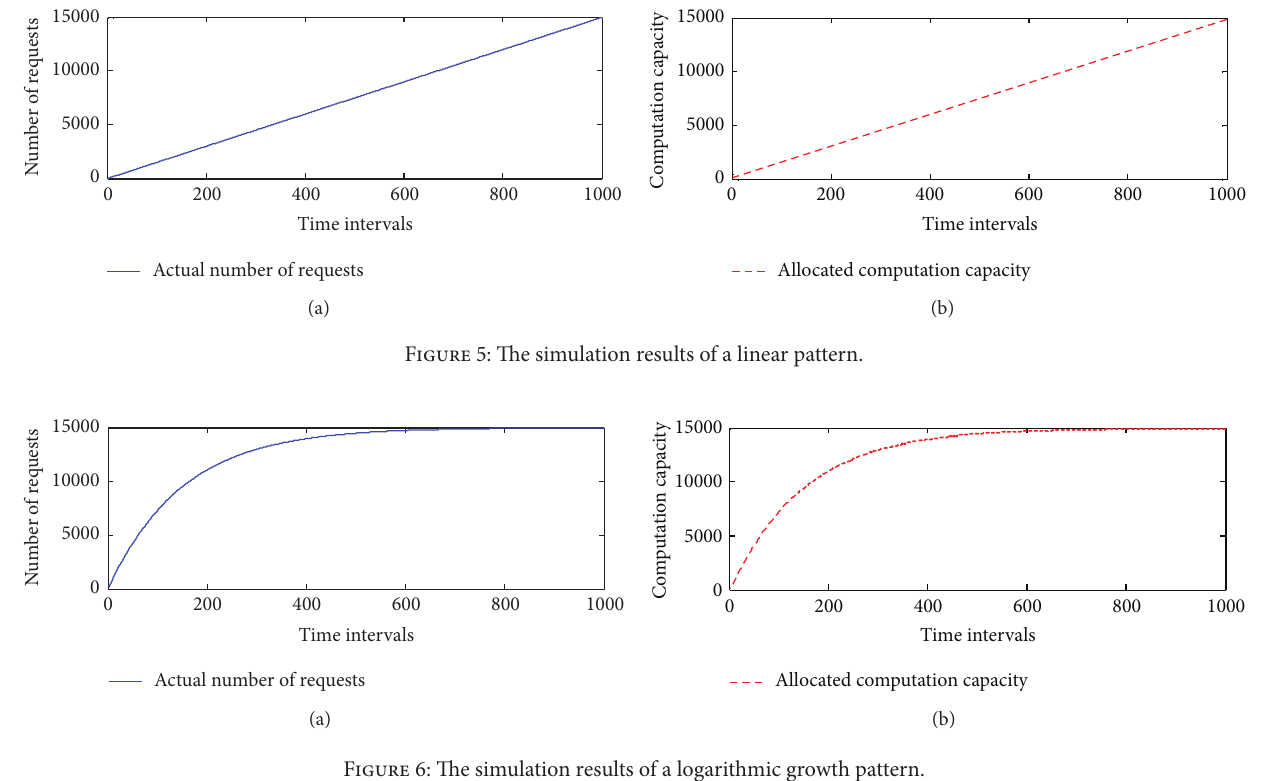
Figure 6: The simulation results of a logarithmic growth pattern.